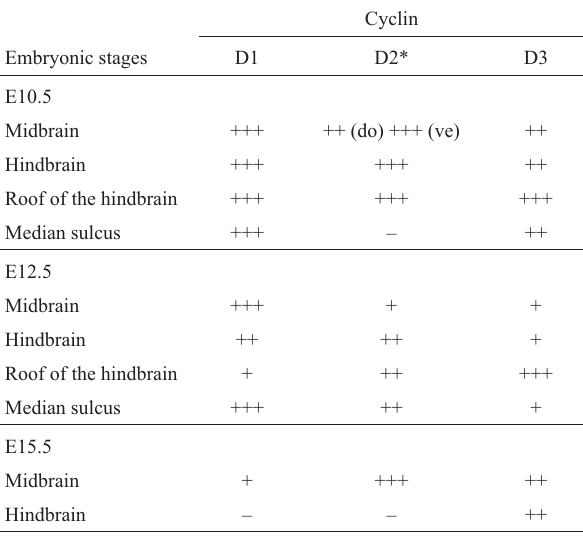
Table 2 - Expression of D-type cyclins in the developing mouse mid and hindbrainregion.Thenumberofplussymbolsindicatesthestaininginten- sity (+++ > ++ > +) for each D-type cyclin in the spinal cord at embryonic stages E10.5, E12.5 and E12.5. A bar (–) denotes negligible